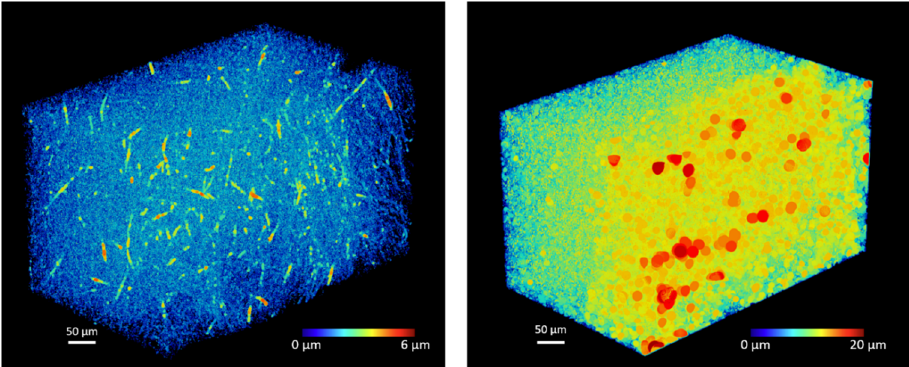
Figure 3. Distribution of left : fibers diameter and right : pores diameter on a 500 × 300 × 300 µm 3 volume of interest.